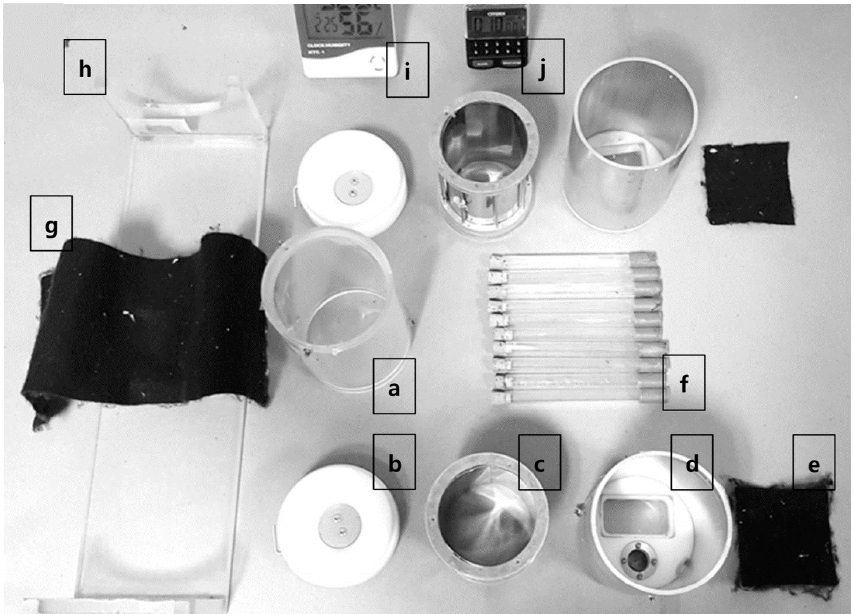
Figure 1. Assembly parts of high-throughput screening system: ( a ) middle Plexiglas cylinder; ( b ) funnel cap for connecting chambers and opening/closing butterfly doors; ( c ) inner metal drum for holding filter paper; ( d ) outer metal chamber; ( e ) fabric window cover of the outer metal chamber; ( f ) mosquito holding tubes; ( g ) fabric to cover the transparent middle cylinder; ( h ) cradle to place the HITSS assembly; ( i ) hygrometer; ( j ) timer.